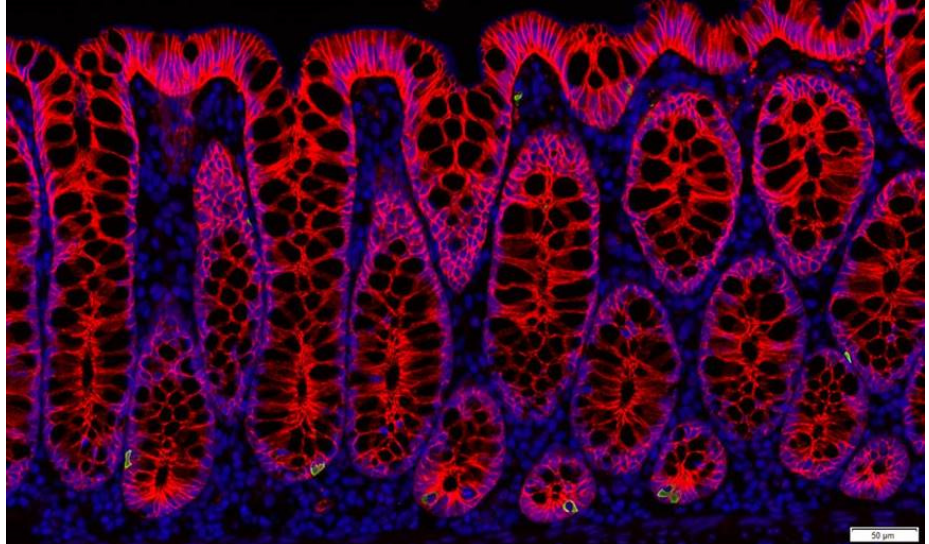
Figure 2. Enteroendocrine L-cells in non-human primate colon (Cynomolgus macaque). L-cells are identified by immunostaining for GLP-1 (green). Nuclei are labelled by DAPI (blue) and the intestinal cells are outlined by e-cadherin staining (red).